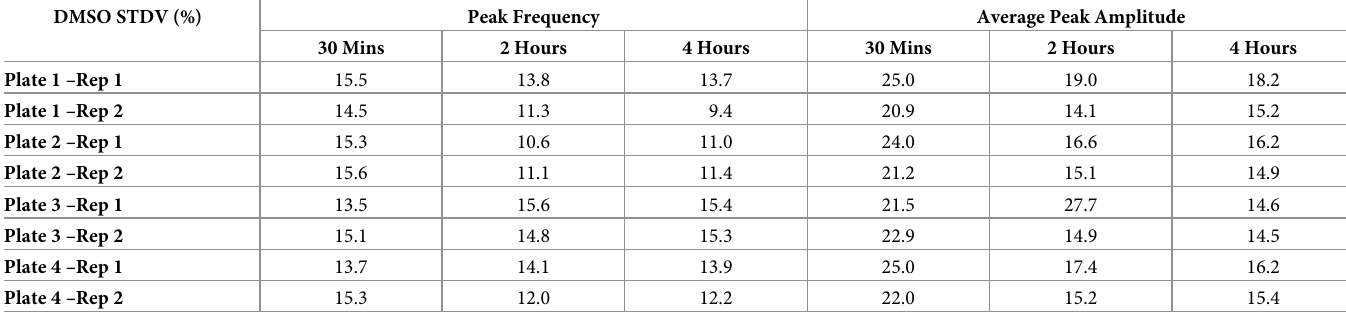
Table 1. Standard deviation of peak frequency and average peak amplitude at each time point in DMSO treated wells from each 384 well plate. DMSO STDV (%) Peak